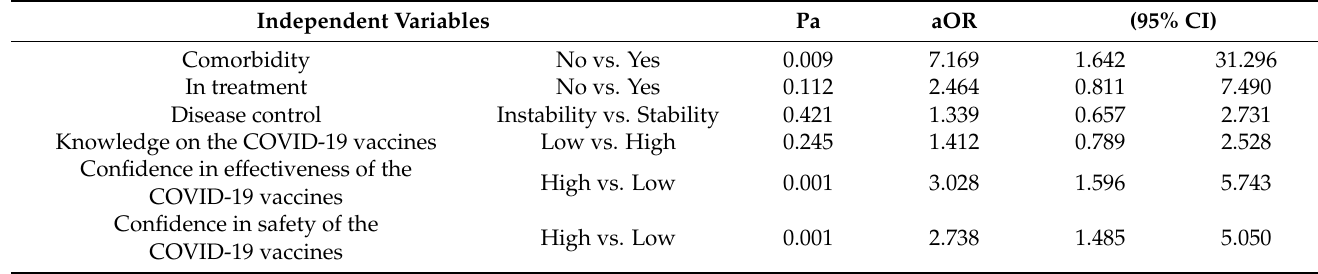
Figure 2. Willingness to accept the booster dose of COVID-19 vaccine, N = 410. p -value < 0.05. Table 3. Factors associated with willingness to accept booster dose of COVID-19 vaccine, N =